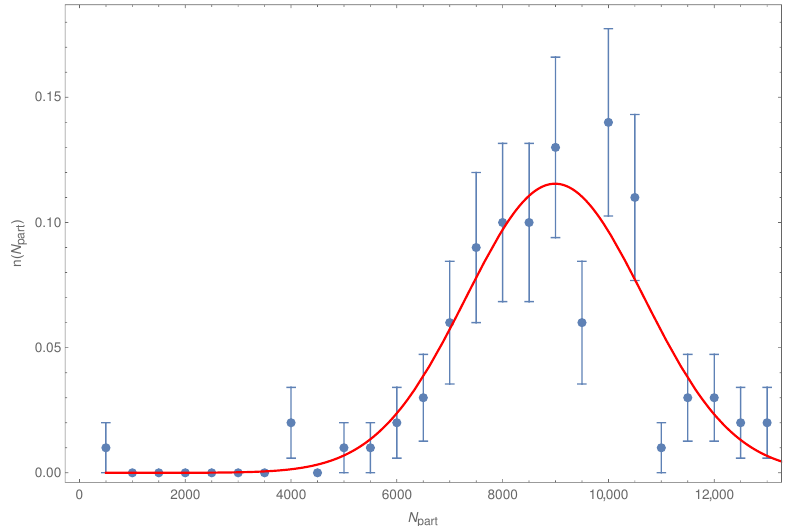
Figure 9. Probability distribution of the number of muons in cascades initiated by protons with energy E = 1000 TeV. The line is the fitted Gaussian function.